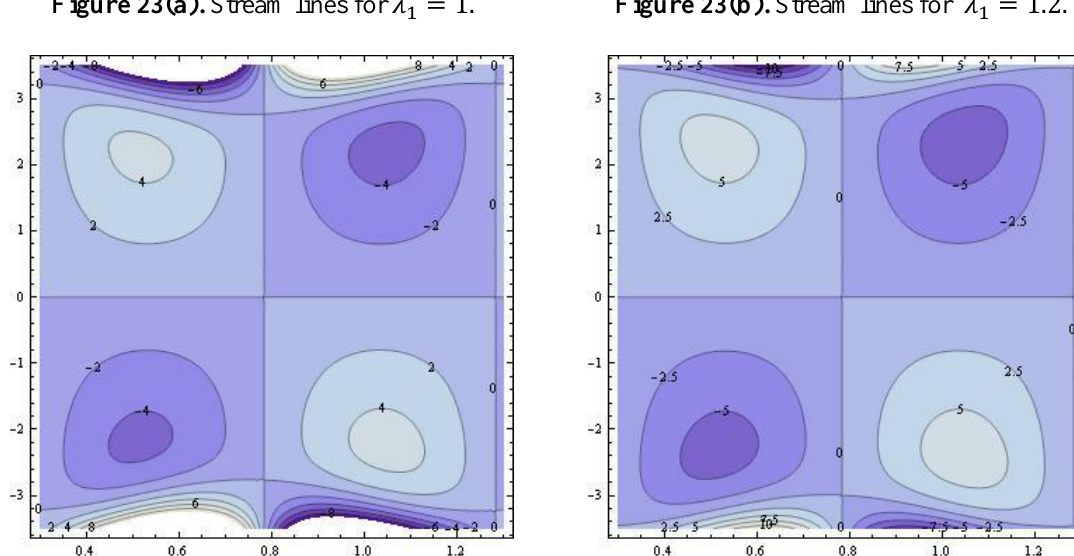
Figure 23(a). Stream lines for 𝜆